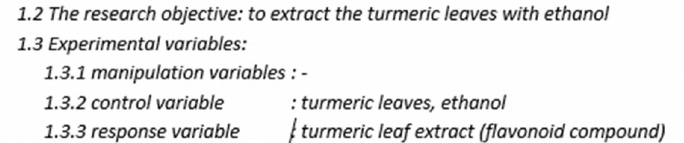
Figure 6. examples of student answers who got a score of 3 in writing